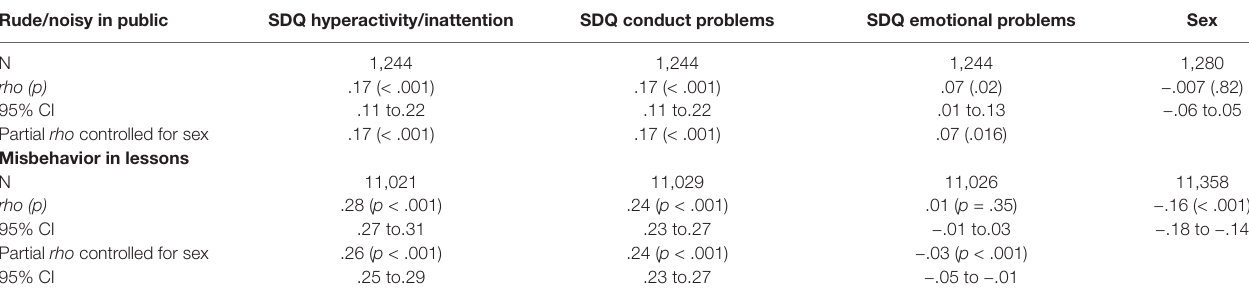
TABLE 1 | Association between NOSI indicators and indicators of hyperactivity, conduct, and emotional problems. Rude/noisy in